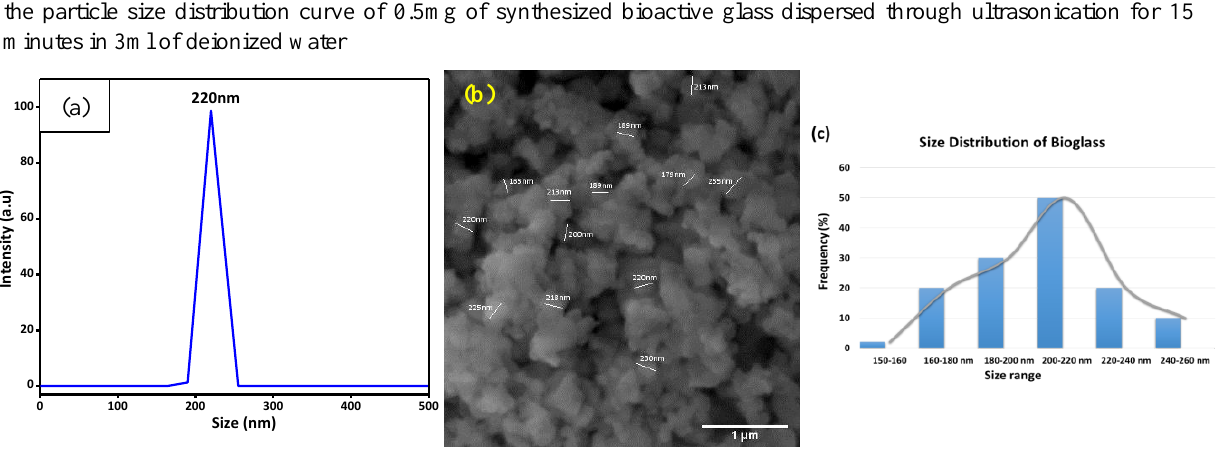
Figure 5. (a) Particle Size Analysis; (b) 25kX Magnification; (c) Size distribution of